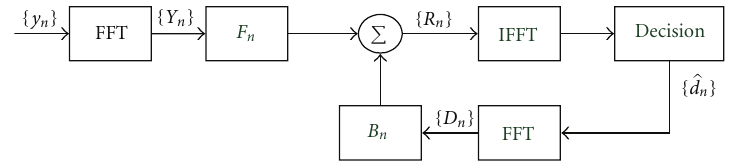
Figure 2: Block diagram of iterative FD-DFE.